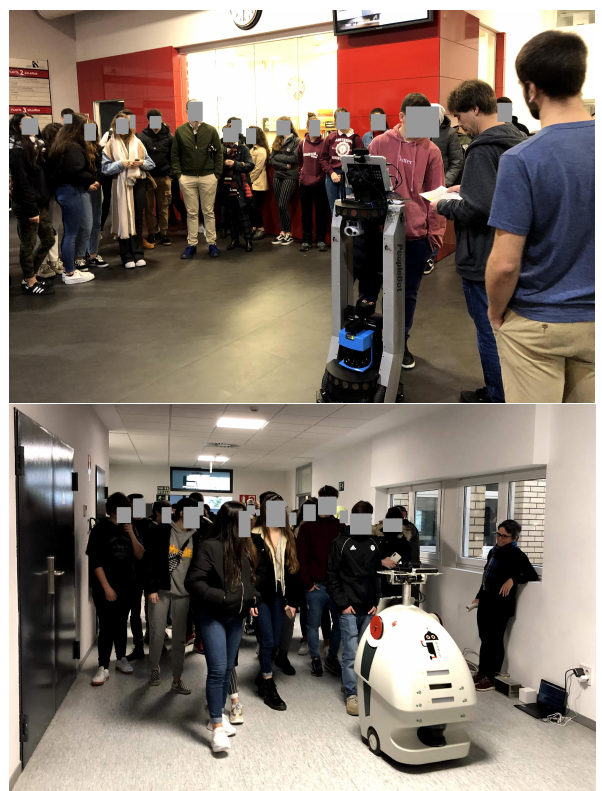
Figure 13. Xare 2019 event at the Faculty of